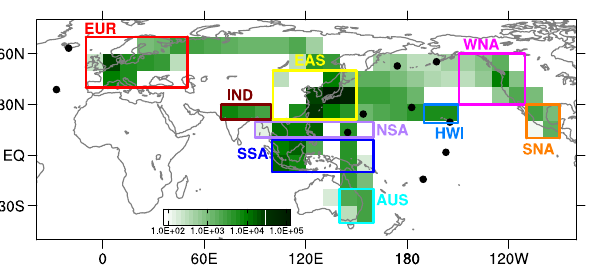
Fig. 1. Number of data in each latitude-longitude grid (10 ◦ × 10 ◦ ) (green shaded) and area distinctions used for the analyses in this study: Europe (EUR: 40–70 ◦ N, 10 ◦ W–50 ◦ E), western North